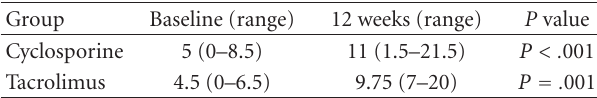
Table 1: Median tear production (STT) inmm/min at baseline and week 12 for the cyclosporine group and the tacrolimus group.